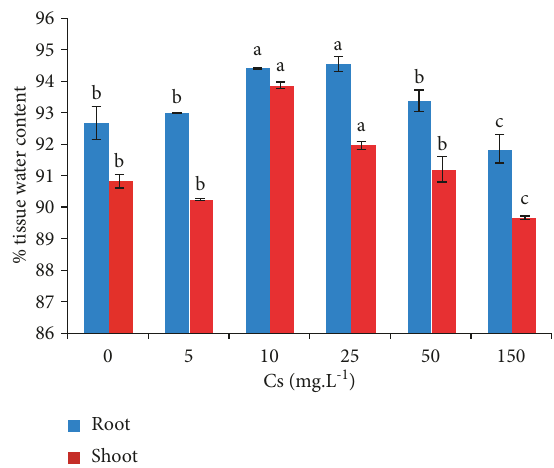
Figure 3: Effect of cesium on % tissue water content of S. portulacastrum. All the values are mean of twelve readings ± S.E. One-way ANOVA significant at p ≤ 0.05. Different letters indicate significantly different values in root or shoot (DMRT p ≤ 0.05).